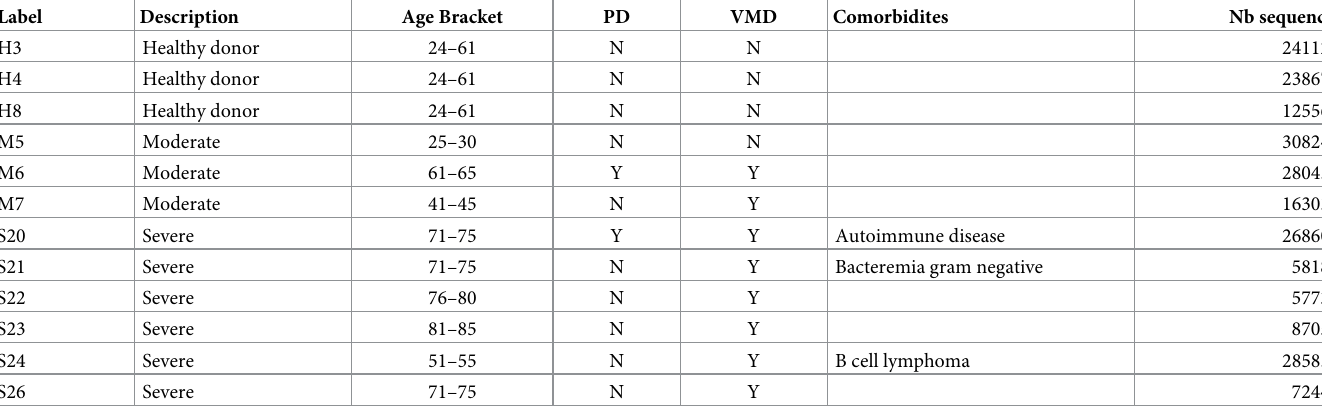
Abbreviations: PD: Pulmonary Disorder (asthma, sarcoidosis, chronic obstructive pulmonary, disease or interstitial lung disease); VMD: Vascular and metabolic disorder (obesity, cardiovascular disease, hypertension, diabetes mellitus and hyperlipidemia) Nb: number; Y, yes. N, no; [source